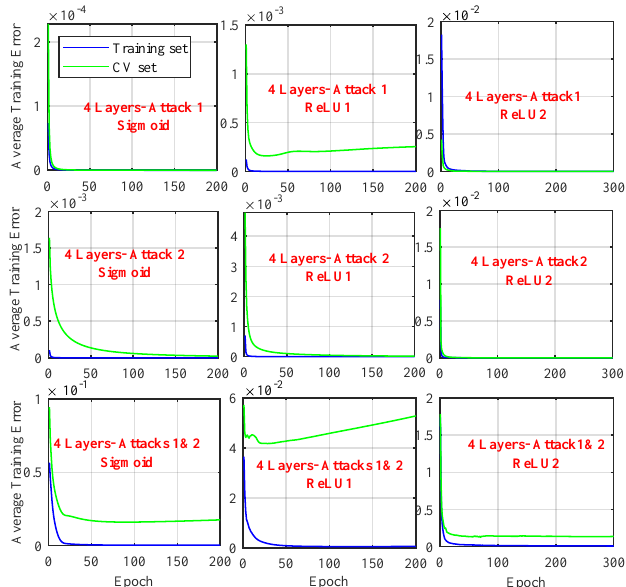
Figure 3. Average of training and cross validation errors for a 4-layer DNN (i.e., 2 hidden layers) are exhibited. The left column demonstrates the results associated with sigmoid and softmax functions for the first and second hidden layers, respectively; the middle column describes the results of using ReLU and softmax in the first and second hidden layers, respectively; and on the right column, the results of using ReLU function in both hidden layers are illustrated. From the top, the top row subplots refer to the detection algorithm against attack 1, the middle row is associated with attack 2, and the bottom row explains detection of simultaneous attacks 1 and 2.